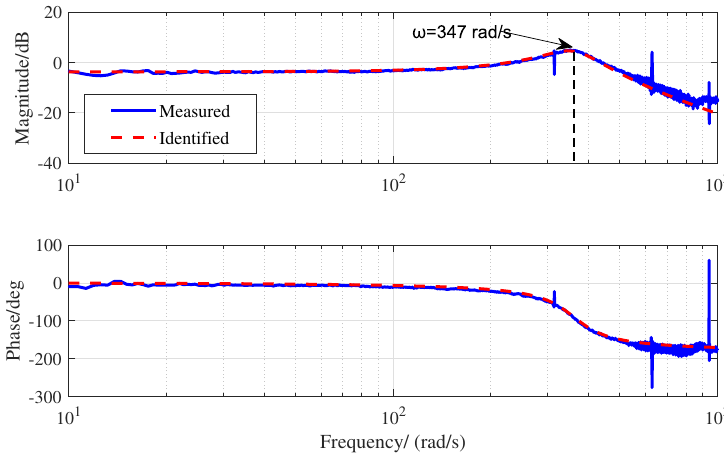
Figure 15. Measured frequency response and Bode